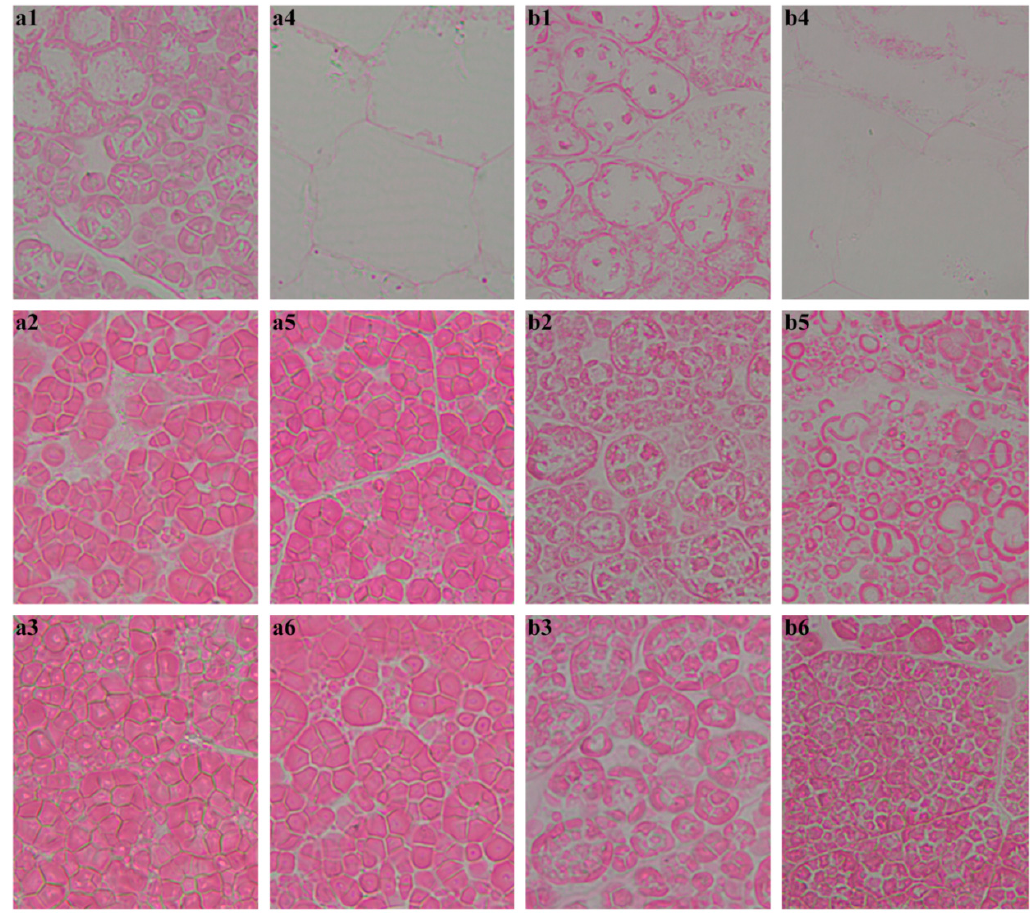
Figure 8. The morphology of the endosperm starch in the GTR seed during seedling growth. ( a ) 4 DAI; ( b ) 8 DAI; (1, 2, 3, 4, 5, 6) the magnification of the square area shown in Figure 6. The section is stained with Schiff ′ s reagent. Scale bar = 20 µm.